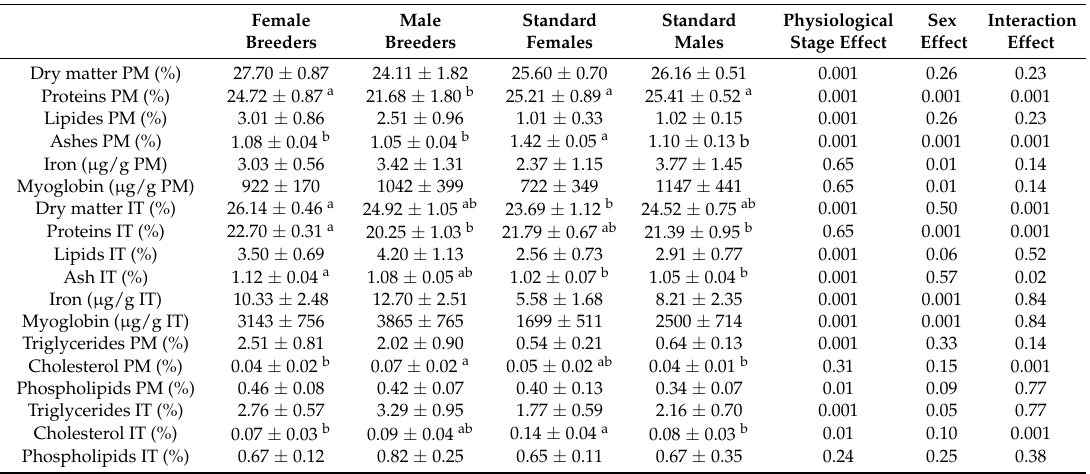
Table 3. Nutritional quality of meat from males and females of breeder and standard turkeys ( n = 10).